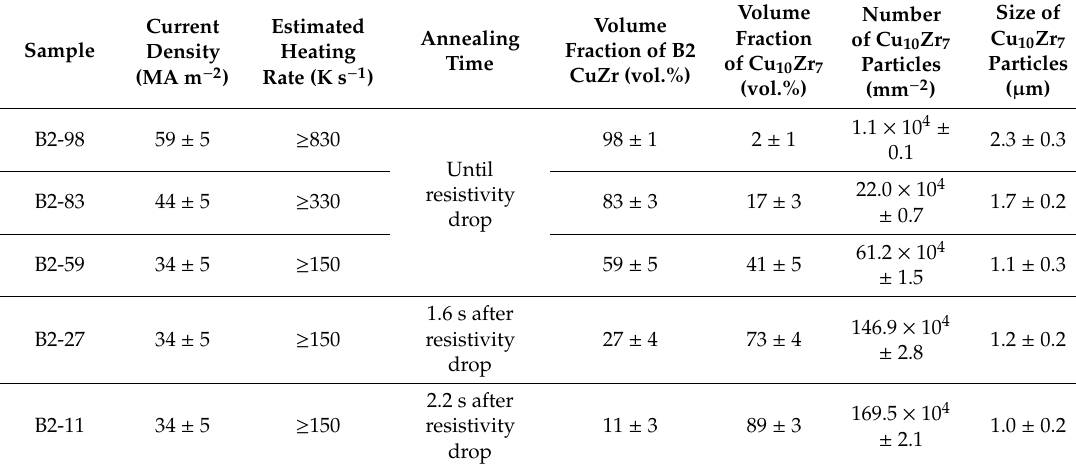
Table 1. Microstructural characteristics of the Cu 47.5 Zr 47.5 Al 5 metallic glass samples rapidly annealed until the resistivity